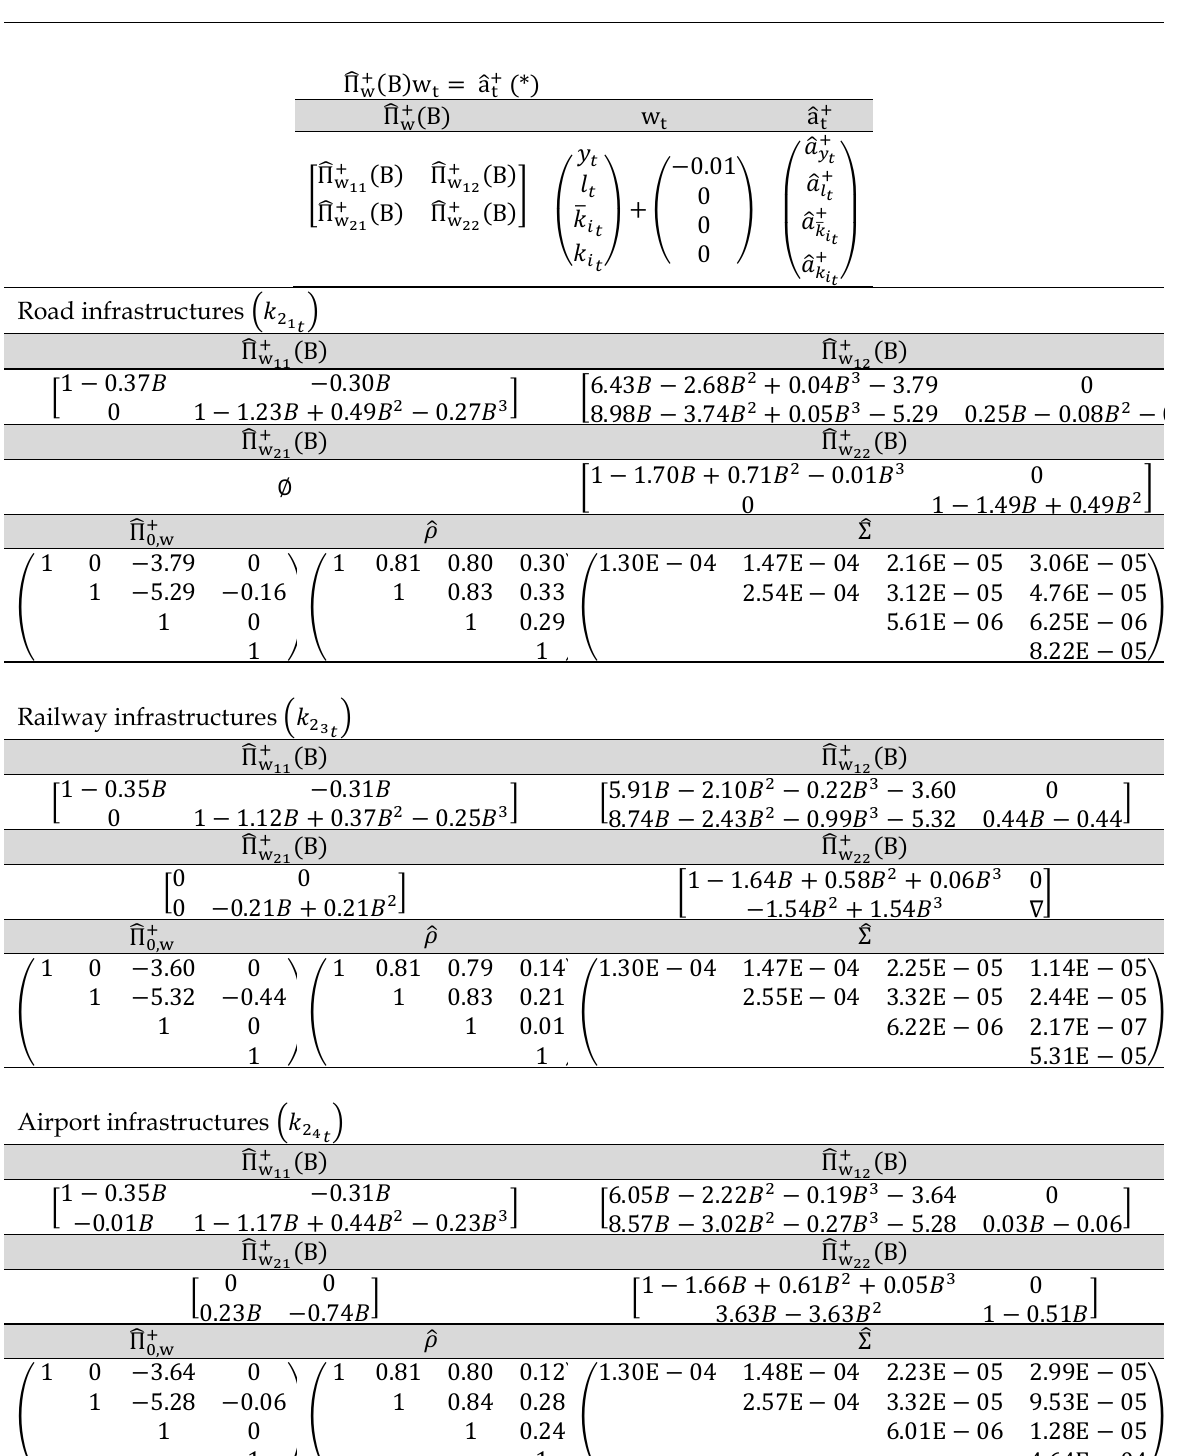
Table 5. Orthogonalized Reduced